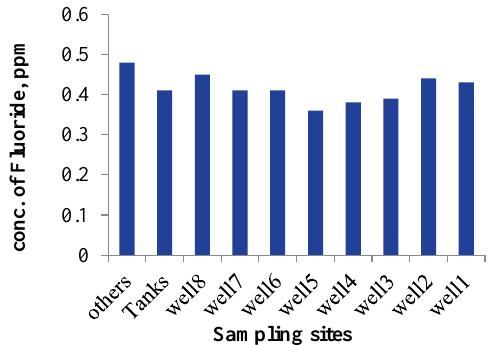
Figure 1. The average of fluoride (mg/l) in well, Tanks and others 2008-2013